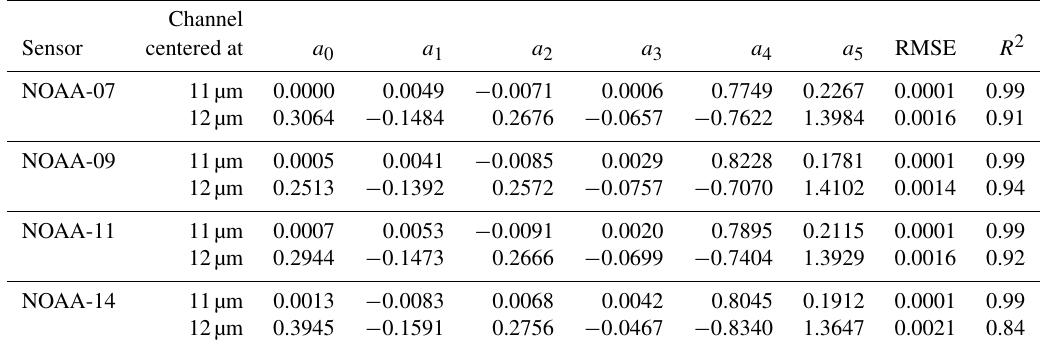
Table 6. Coefficients for converting bare soil emissivity from ASTER to AVHRR (see Sect. 3.3). Channel